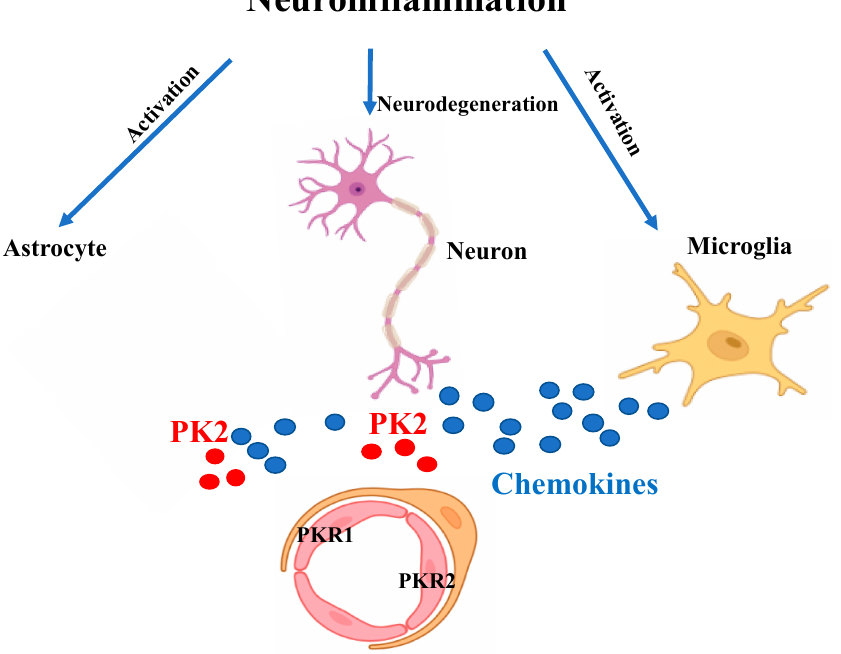
Figure 2. Schematic representation of the inflammatory state. Neuroinflammation leads to neurodegeneration and to over-activation of microglia and astrocytes which release pro-inflammatory cytokines and chemokines (blue circles). The chemokine-like protein PK2 (red circles) is secreted by neurons and astrocytes. Upon binding to PKR1 and PKR2 receptors on endothelial cells it promotes angiogenesis and vascular permeability.